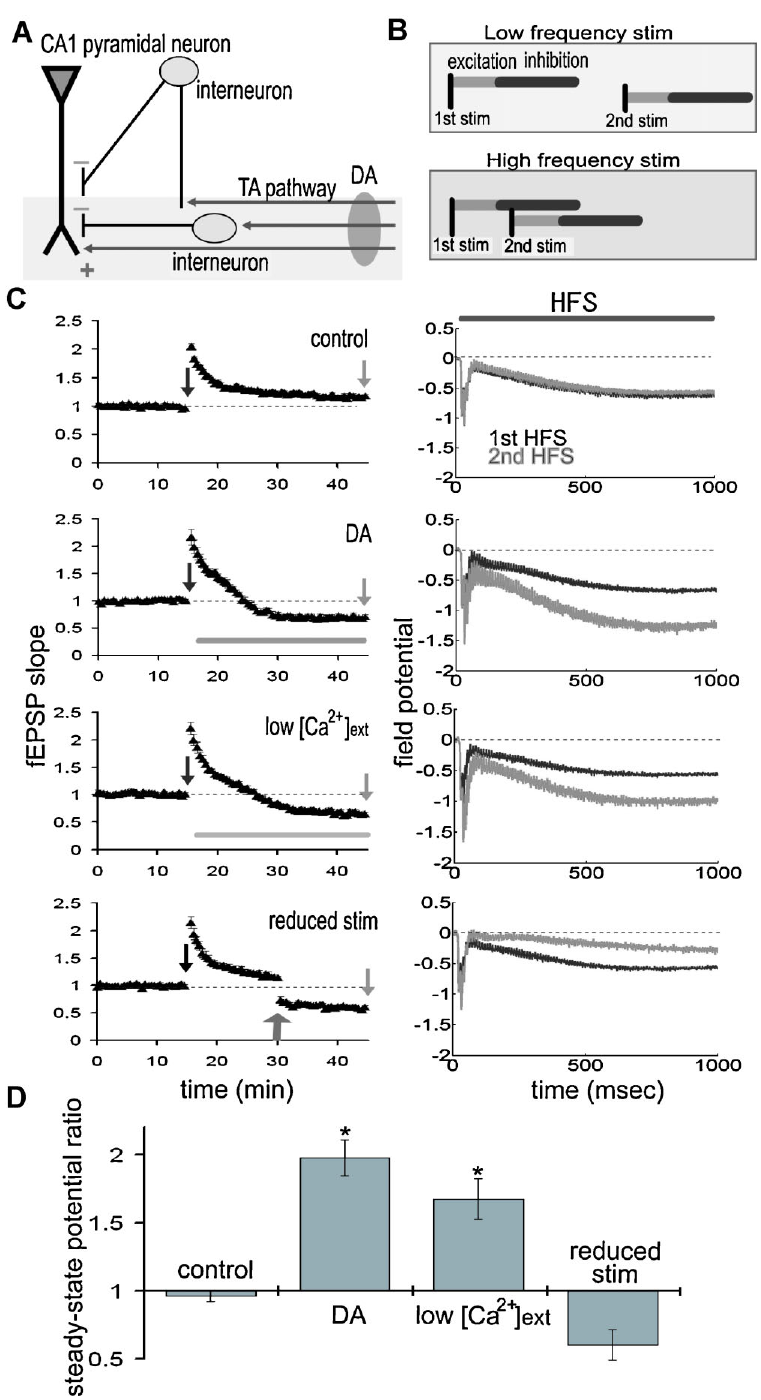
Figure 3. DA augments the steady-state field potential induced by HFS . ( A ) Scheme of the TA-CA1 synapse. The TA axons make excitatory connections with both pyramidal neurons and interneurons. Interneurons in turn inhibit pyramidal neurons (feedforward inhibition). Depression of excitatory inputs onto interneurons by DA reduces inhibition of pyramidal neurons. ( B ) Frequency-dependent effect of feedforward inhibition. In contrast to the direct excitatory TA-CA1 input, the TA pathway exerts a disynaptic modulation of inhibition. Thus, the inhibition of pyramidal neurons after TA stimulation is delayed, relative to the excitation. In pyramidal neurons, the TA pathway-evoked inhibition does not affect excitation during low-frequency stimulation, because of the delay in inhibition. However, during HFS, inhibition can effectively suppress subsequent excitatory responses. ( C ) Extracellular field recording from TA-CA1 synapses. Left, HFS was applied at 15 and 45minute (indicated by arrows). Field potential traces during HFS are normalized to the baseline fEPSP amplitude prior to HFS application. The field potential at the end of the HFS (100th stimulus response) was measured (steady-state potential). Right, the average waveforms during HFS are shown. DA: after first HFS, DA was applied (indicated by bar). Low [Ca 2+ ] ext : after first HFS, the extracellular calcium concentration was reduced from 2.5 to 1.25mM (indicated by bar). Reduced stimulus: at 30minute, the stimulation current was reduced to produce a small fEPSP comparable to that observed during DA application (indicated by arrow) (n = 5 for each group). ( D ) Ratio of steady-state potentials observed during second and first HFS epochs. DA application induced a significantly (p<0.01) larger steady-state potential that was also mimicked by reduction of [Ca 2+ ] ext